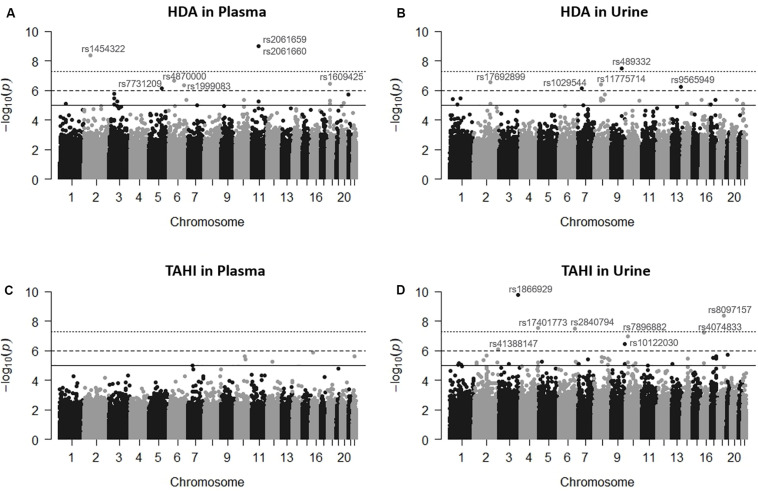
Manhattan plots showing the single-nucleotide polymorphisms (SNPs) significantly associated with 1,6-diaminohexane (HDA) in plasma (A) and urine (B) and trisaminohexyl isocyanurate (TAHI) biomarker levels in plasma (C) and urine (D) when inhalation and skin exposures to 1,6-hexamethylene diisocyanate (HDI) monomer and HDI isocyanurate were used as covariates, respectively. Urine biomarker levels were adjusted with creatinine level. The solid line is the suggestive significance default line at -log10(p = 1 × 10–5), the dashed line is equivalent to false discovery rate (FDR) = 0.10 at −log10(p = 1 × 10–6), and the top dotted line is the genome-wide significance default line at −log10(p = 5 × 10–8).